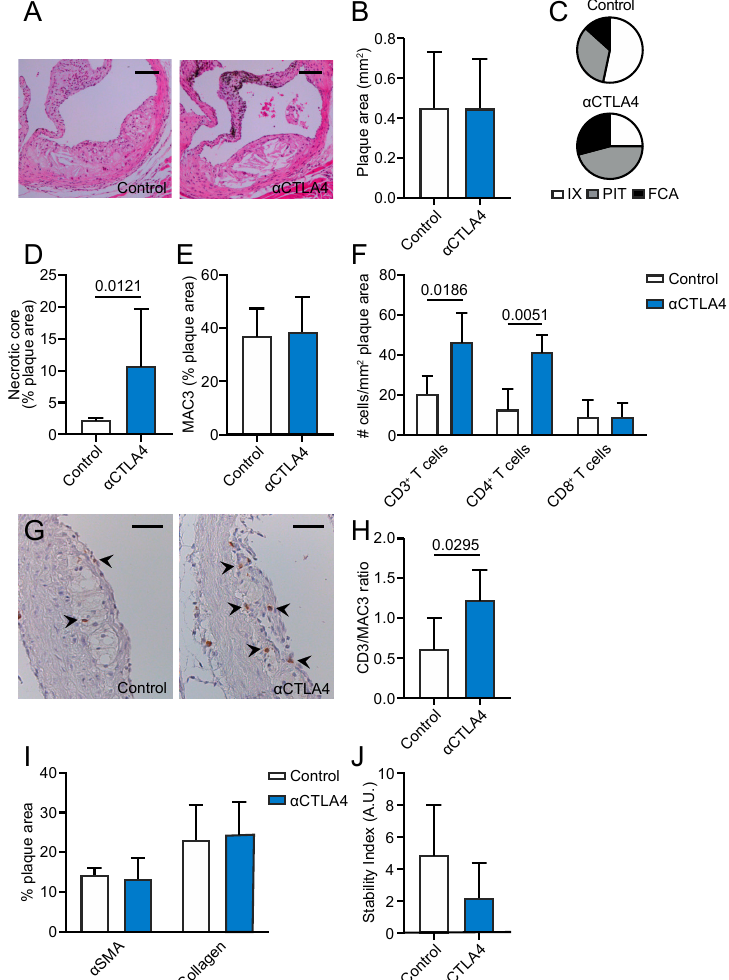
Figure 4. Antibody-mediated inhibition of CTLA4 promotes the progression of atherosclerosis in the aortic root. ( A ) Representative pictures of plaques in the aortic root (haematoxylin and eosin staining). Scale bar: 200 μ m. ( B ) Atherosclerotic plaque area in the aortic root ( n = 5–9). ( C ) Morphological analysis of the atherosclerotic plaque phenotype according to the Virmani Classification. ( D ) Quantification of necrotic core area in plaques. ( E ) Quantification of plaque macrophage content. ( F ) Immunohistochemical quantification of CD3 + , CD4 + , and CD8 + cells. ( G ) Representative pictures of CD3 + cells in the plaque. Scale bar: 150 μ m. ( H ) The CD3/MAC3 ratio in the plaques. ( I ) Quantification of smooth muscle actin and collagen content in the plaques. ( J ) The stability index (smooth muscle actin positive area % / necrotic core area %). FCA = fibrous cap atheroma, IX = intimal xanthoma, PIT = pathological intimal thickening .